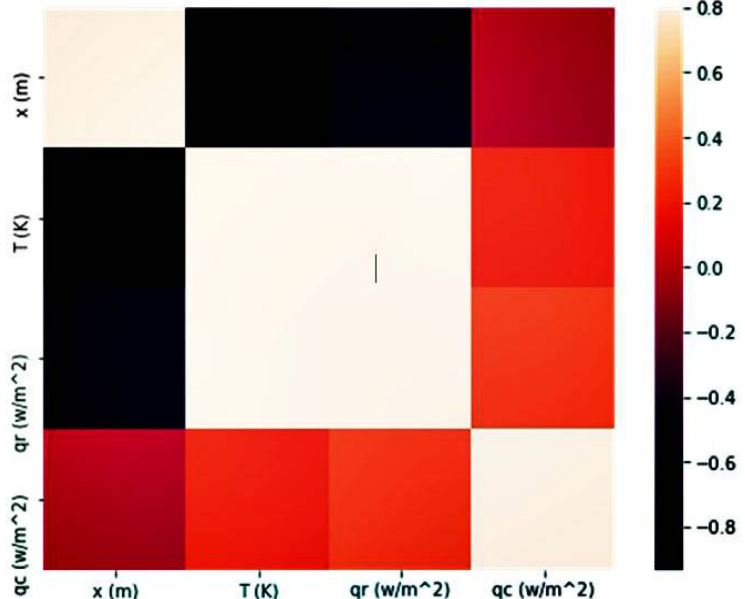
Figure 7. The correlation matrix between parameters.